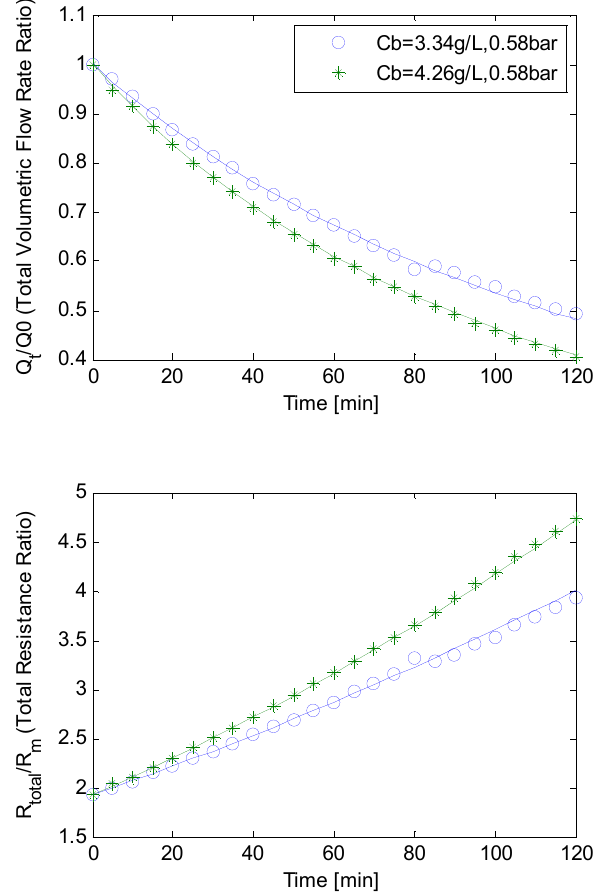
Figure 8. Flux decline and total resistance for flux step at TMP 58 kPa for